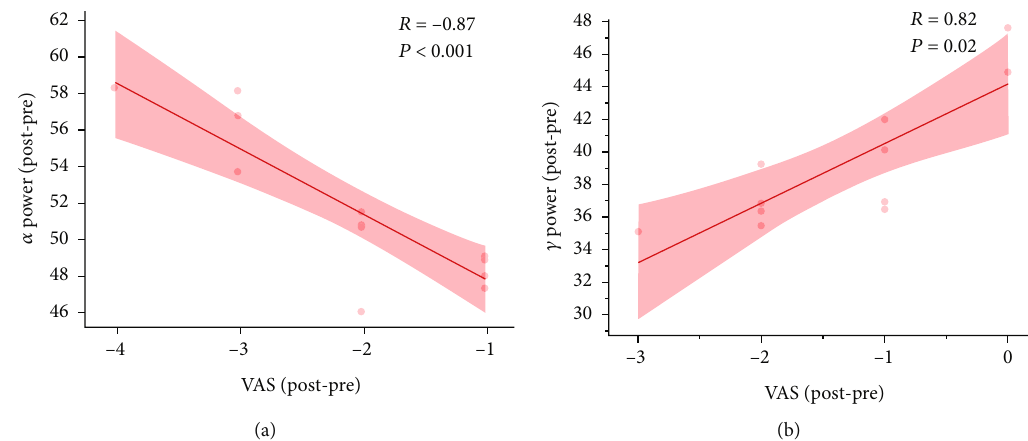
Figure 5: α and γ power changes were signi fi cantly correlated with tinnitus VAS scores. α power change were negatively correlated with VAS scores ( R = − 0 : 87 , p < 0 : 001 ) (a). γ power change was positively correlated with VAS scores ( R = 0 : 82 , p = 0 : 02 ) (b). VAS score reduction, represented by negative values, denotes the clinical improvement of the patient